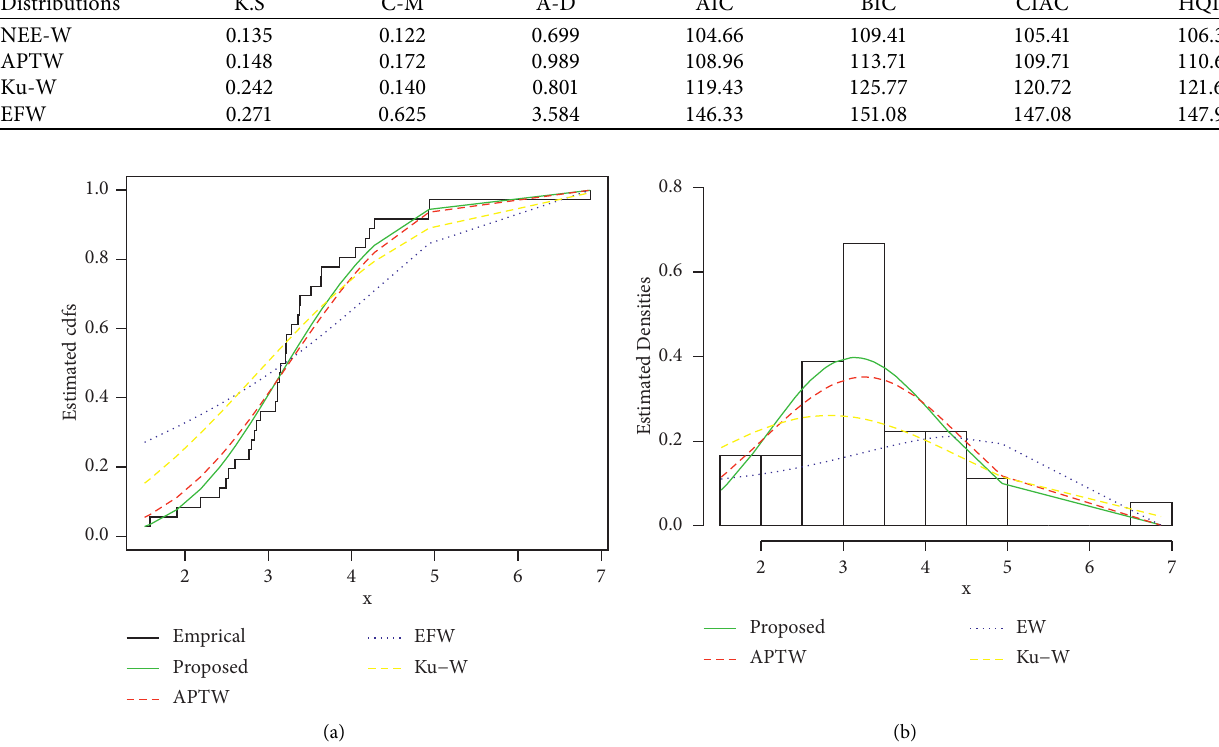
Figure 5: Fitted plots of joint CDF and pdf for the proposed and four competing distributions.